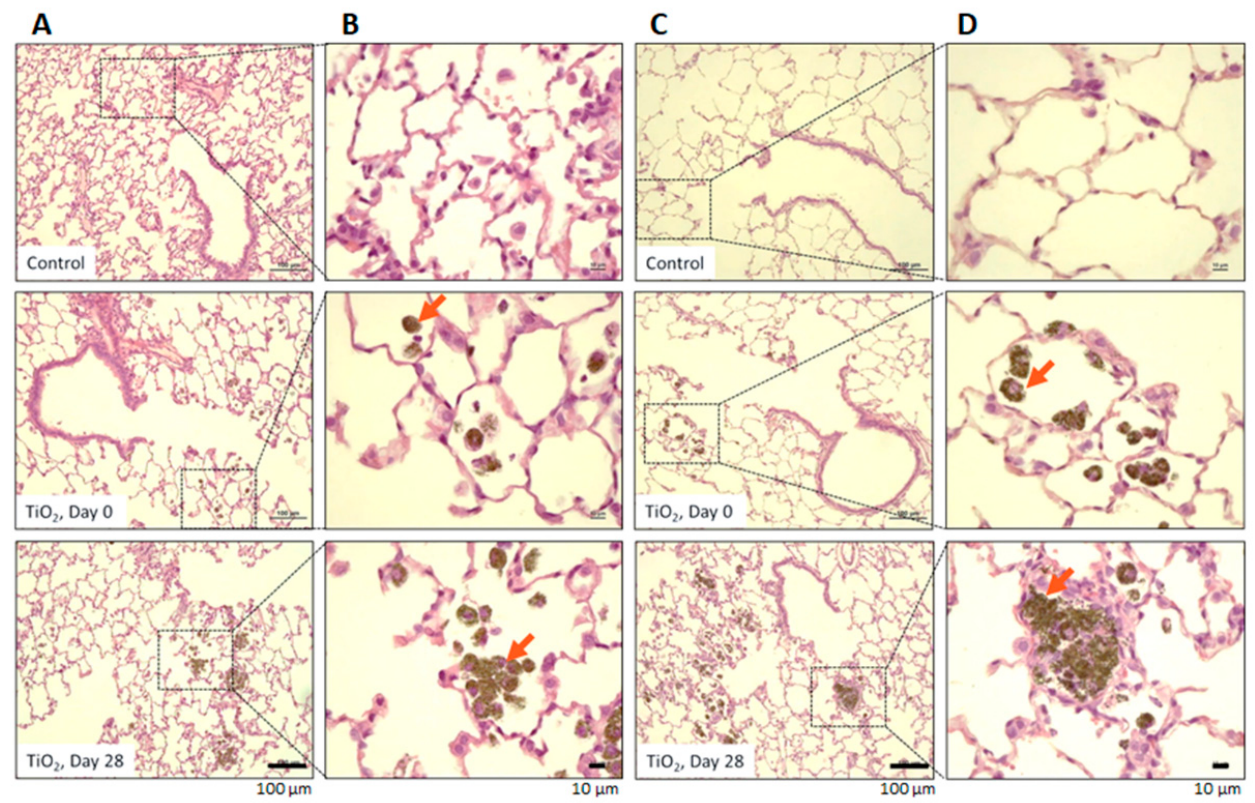
Figure 2. Lung Histopathology: Representative microscopy images of hematoxylin-eosine stained lung sections of controls and exposed to TiO 2 aerosol of both age. ( A , B ) are from lungs of young control and exposed rats, ( C , D ) are from lungs of elderly control and exposed rats. Red arrows indicate macrophages containing nanoparticles. ( A , C ) magnification × 40; ( B , D ) magnification ×